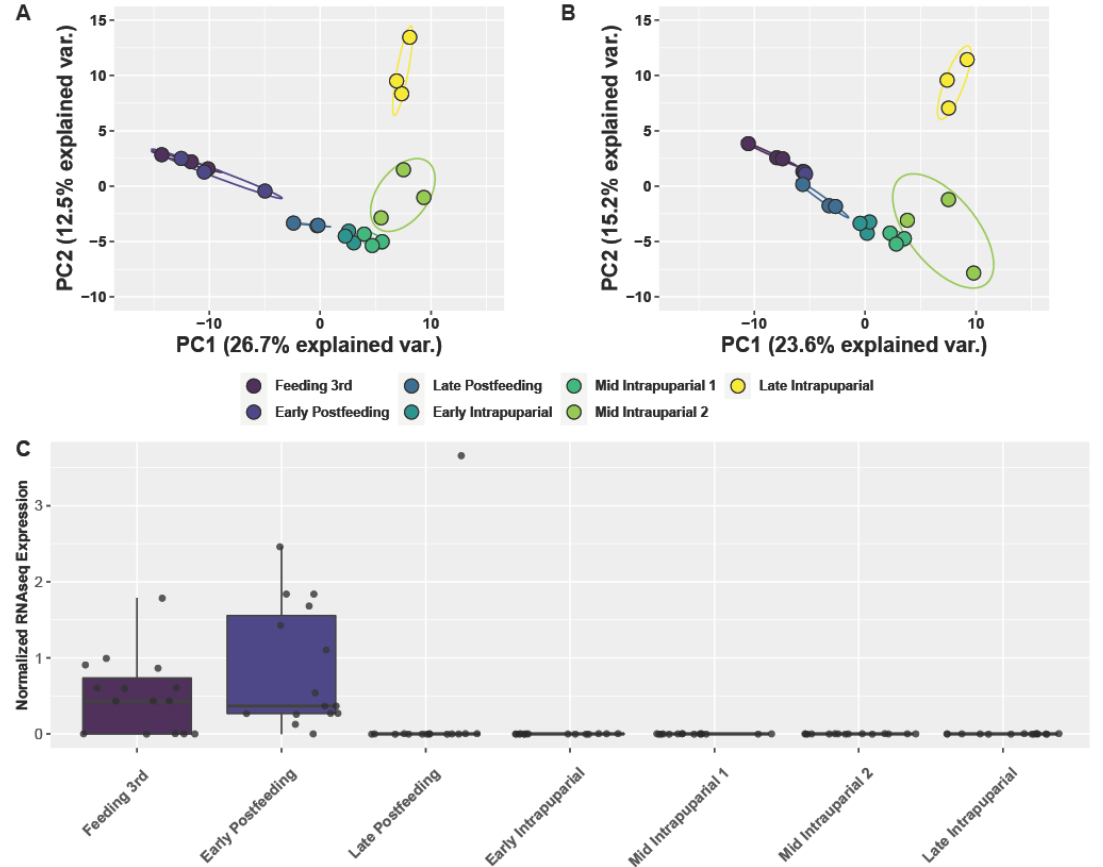
Figure 1. Identification and impact of vertebrate miRNA on the prediction of the development of immature C. macellaria. ( A ) PCA of normalized expression information for all identified miRNAs across development of C. macellaria . ( B ) PCA of normalized expression information for all identified miRNA across development of C. macellaria , excluding those which were matched to vertebrates from the database. Removing these vertebrate sequences had a modest effect on the percent variance explained, but was able to separate the feeding 3rd instar and early postfeeding 3rd instar larval samples. ( C ) Boxplot with jitterplot of miRNA levels for miRNA identified to be from Bos taurus , the provided food source, across immature developmental stages. Expression level drops to nothing after the early postfeeding 3rd instar stage.